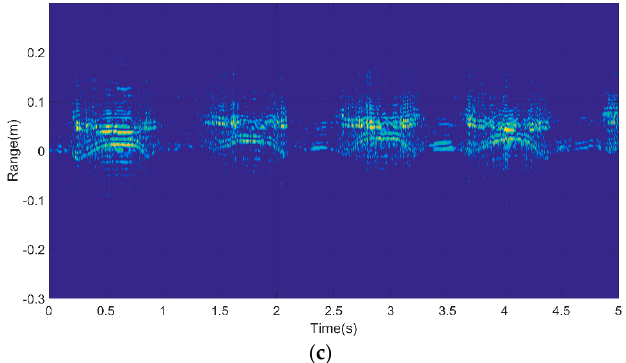
Figure 8. HRRP sequences of three gestures: ( a ) G1; ( b ) G2; ( c ) G3.